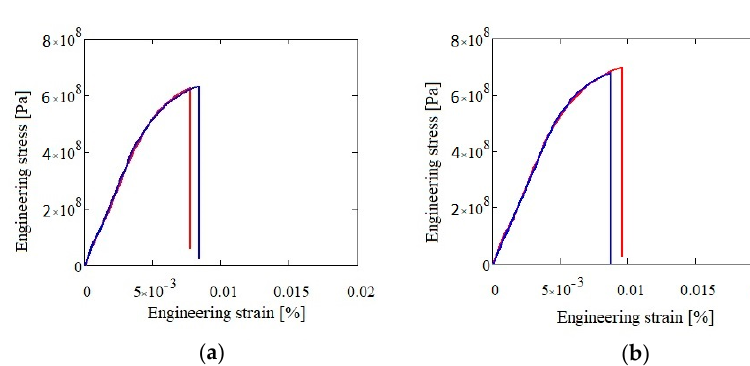
Figure 23. Compression test results for as-cast ( a ) and heat treated ( b ) Al 3 Mn 0.2 Zn 0.3 Mg 0.7 Si 0.8 alloy.